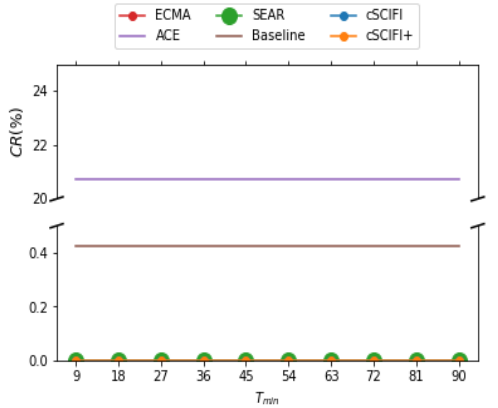
Figure 6. Coverage ratio loss for different T min